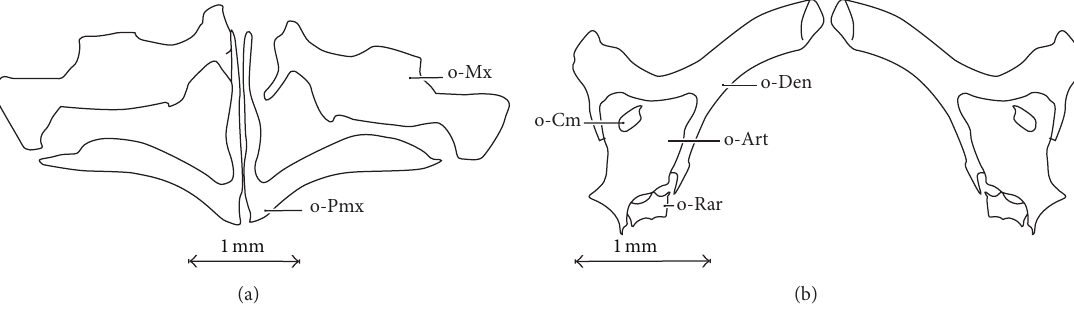
Figure 3: (a) Upper jaw and (b) medial view of lower jaw in Oxynoemacheilus chomanicus Art: articulare; Cm: coronomeckelian; Den: dental; Mx: maxilla; Pmx: premaxillary; Rar: retroarticular.